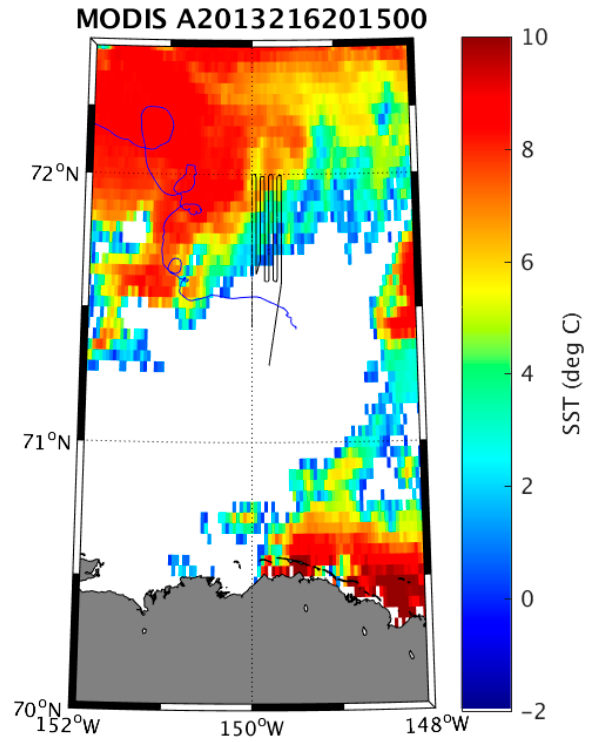
Figure 1. Ball Experimental Sea Surface Temperature (BESST) lawn mower survey during the Marginal Ice Zone Observations and Processes Experiment (MIZOPEX) (black). The aircraft entered the pattern heading northbound at the western edge of the pattern, and exited to the south at the eastern edge. The background image is from the Moderate Resolution Imaging Spectroradiometer (MODIS) AQUA sea surface temperature (SST) granule for 20:15 UTC on 4 August 2013, the day of the flight. The blue trace depicts the UpTempO buoy track while in the study area. This buoy was deployed the day after the unmanned aerial vehicle (UAV) survey, and was part of the MIZOPEX in situ instruments.